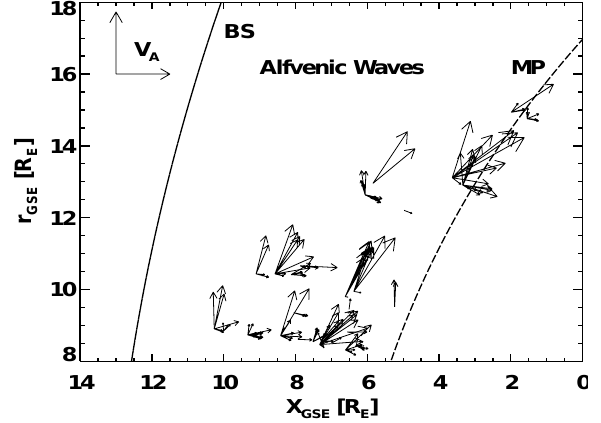
Fig. 15. Velocity vectors V Ph, rest normalized to V A of the Alfv´enic wave events in the GSE coordinate system with q + Z 2 r GSE = Y 2 . GSE GSE